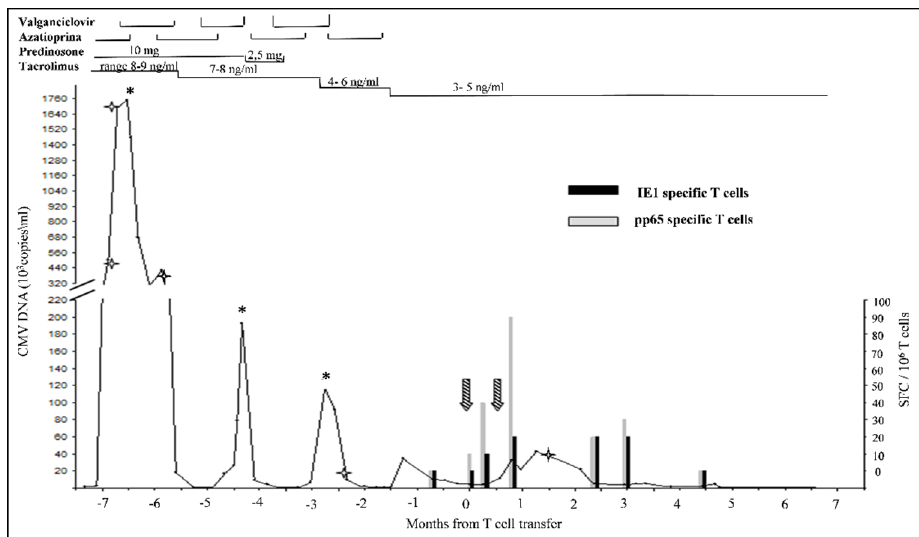
Figure 2. Trends of CMV DNA viral load and IFN- γ secreting T cells following stimulation with peptide mix of IE-1 and pp65 proteins, (SFC: spot forming cells) during 15 months period. Time points of infusion are marked by streaked arrows. The asterisk * indicates GCV administration timepoints. The